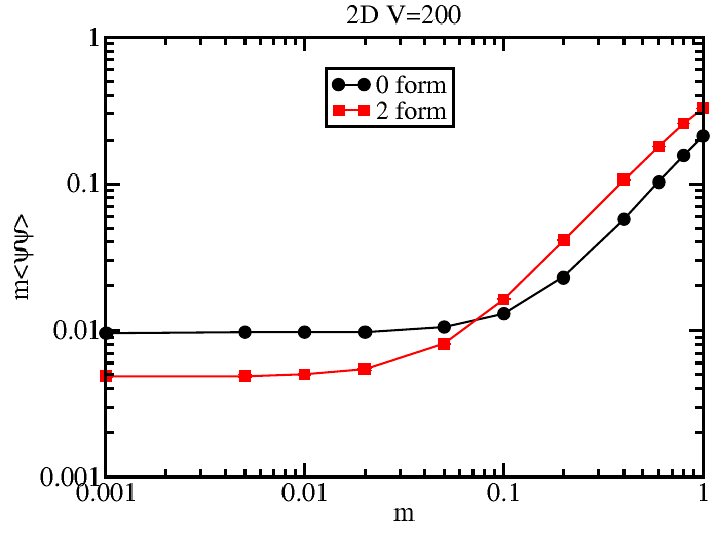
Figure 1 . Bilinear condensates vs bare mass m on S 2 with N 2 = 200 and (cid:12) =